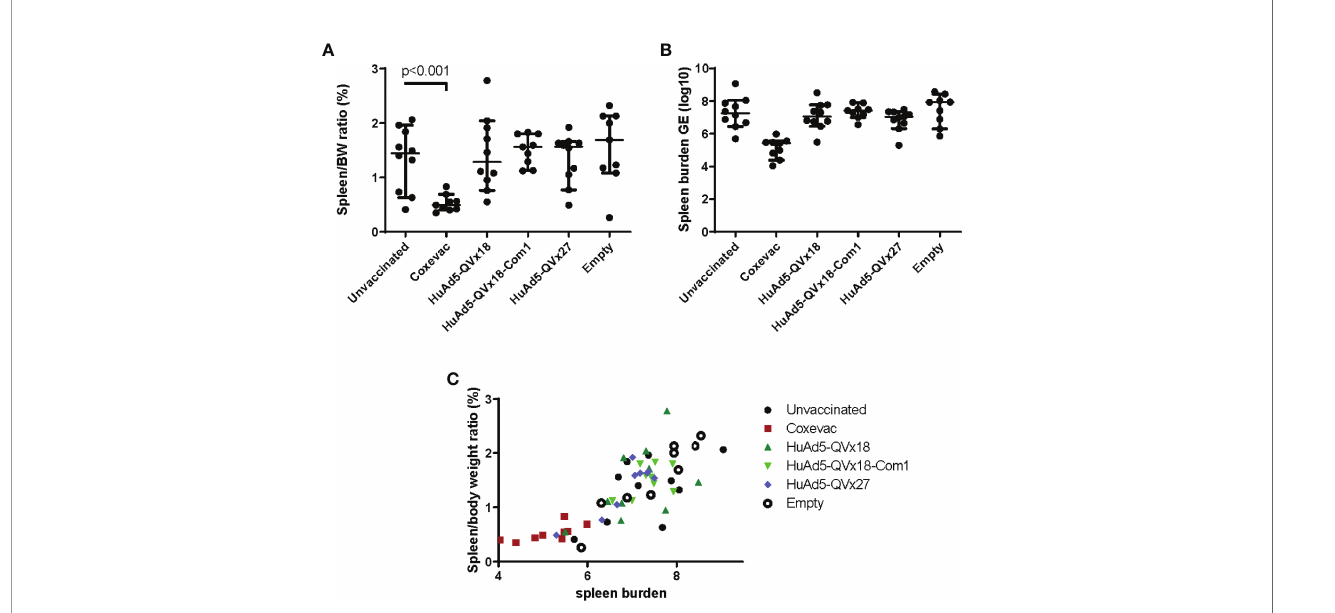
FIGURE 4 | Murine vaccine ef fi cacy study. C57BL/6 mice were vaccinated using a heterologous prime-boost-boost schedule as indicated in Table 2 . Group labels in the graphs indicate the prime vaccine administered. Sixteen days after the second MVA-kQVx27 boost, mice were intranasally challenged with C. burnetii (Nine Mile strain). Mice were euthanized at two weeks after challenge. (A) Spleens were harvested and weighed, and spleen-to-body weight ratio determined. Only the Coxevac ® -immunized group was signi fi cantly different from the unvaccinated control group (p<0.001; two-tailed t test). (B) Splenocytes were collected and the spleen bacterial burden was determined from homogenates by qPCR. No treatment groups were signi fi cantly different from the unvaccinated controls. (C) The relationship between spleen-to-body weight ratio and bacterial burden is plotted for each individual